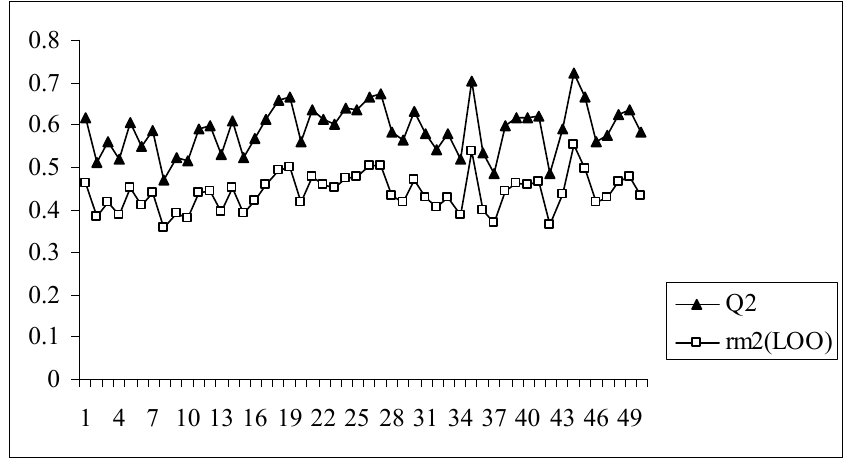
Figure 6. Comparative plots of Q 2 and r m2